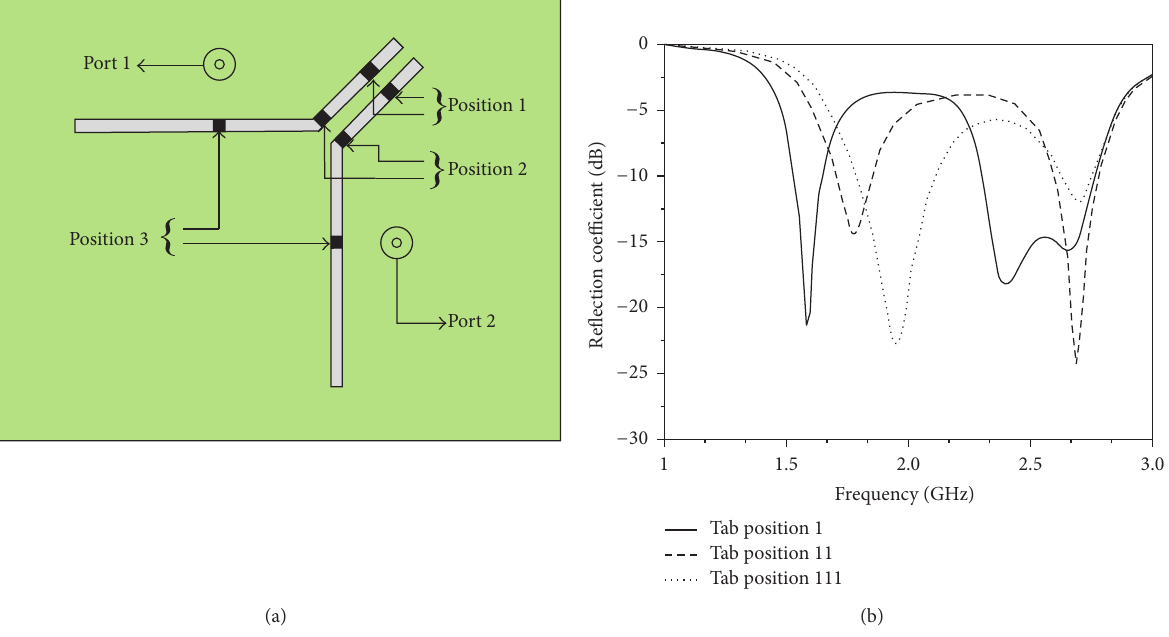
Figure 9: Simulated reflection coefficient for different tab positions.